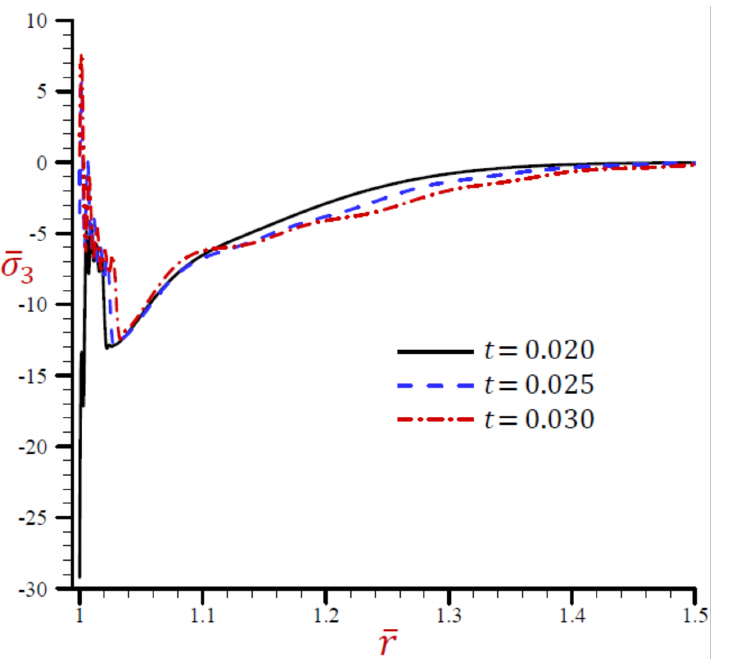
Figure 24. This is a figure. Schemes follow the same formatting Effect of t on radial stress σ 3 across the radial direction of the cylindrical cavity utilizing the RDPL